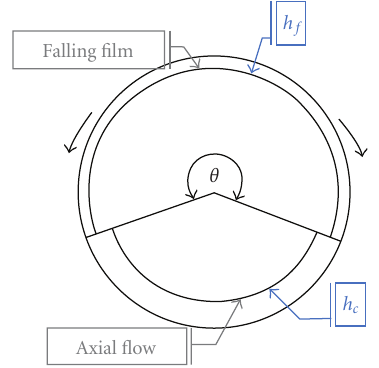
Figure 8: Thome’s flow pattern map for condensation in a horizontal tube. S → stratified SW → stratified wavy A → annular I → intermittent MF → mist flow.